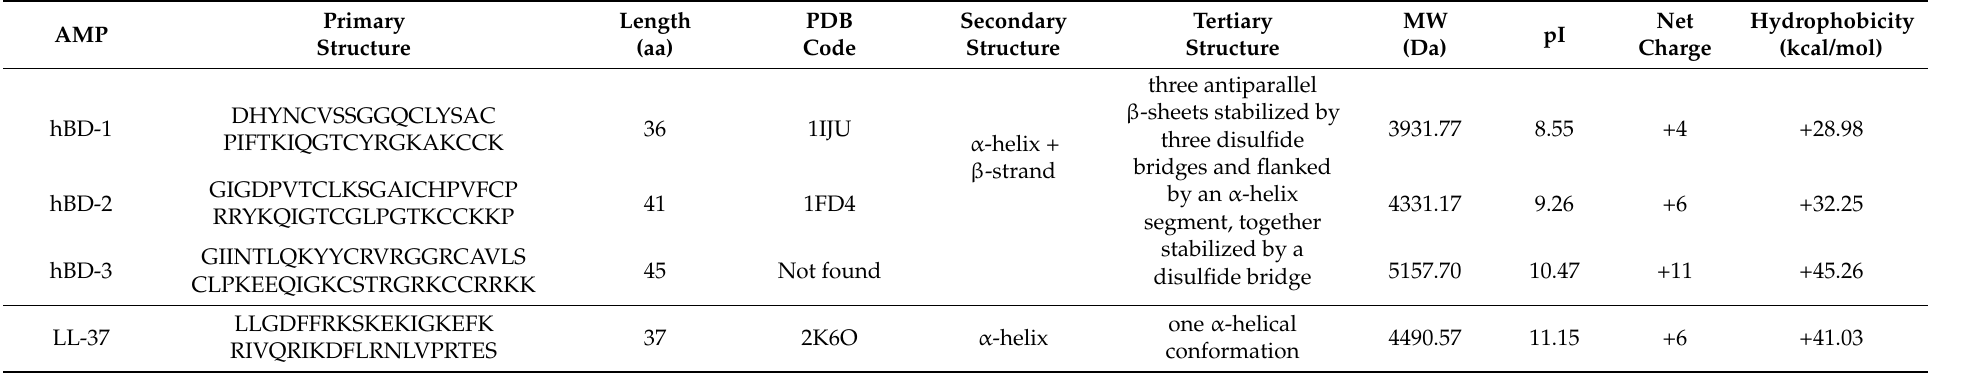
Table 2. Main endogenous AMP primary, secondary, and tertiary structures, and their related physicochemical properties, including length, molecular weight (MW), isoelectric point (pI), net charge, and hydrophobicity. PBD codes were obtained from the Protein Data Bank: www.rcsb.org (accessed on 1 December 2021). The physicochemical properties were obtained from www.pepdraw.com (accessed on 5 December 2021) and confirmed in other similar software, whereas the secondary and tertiary structures were obtained